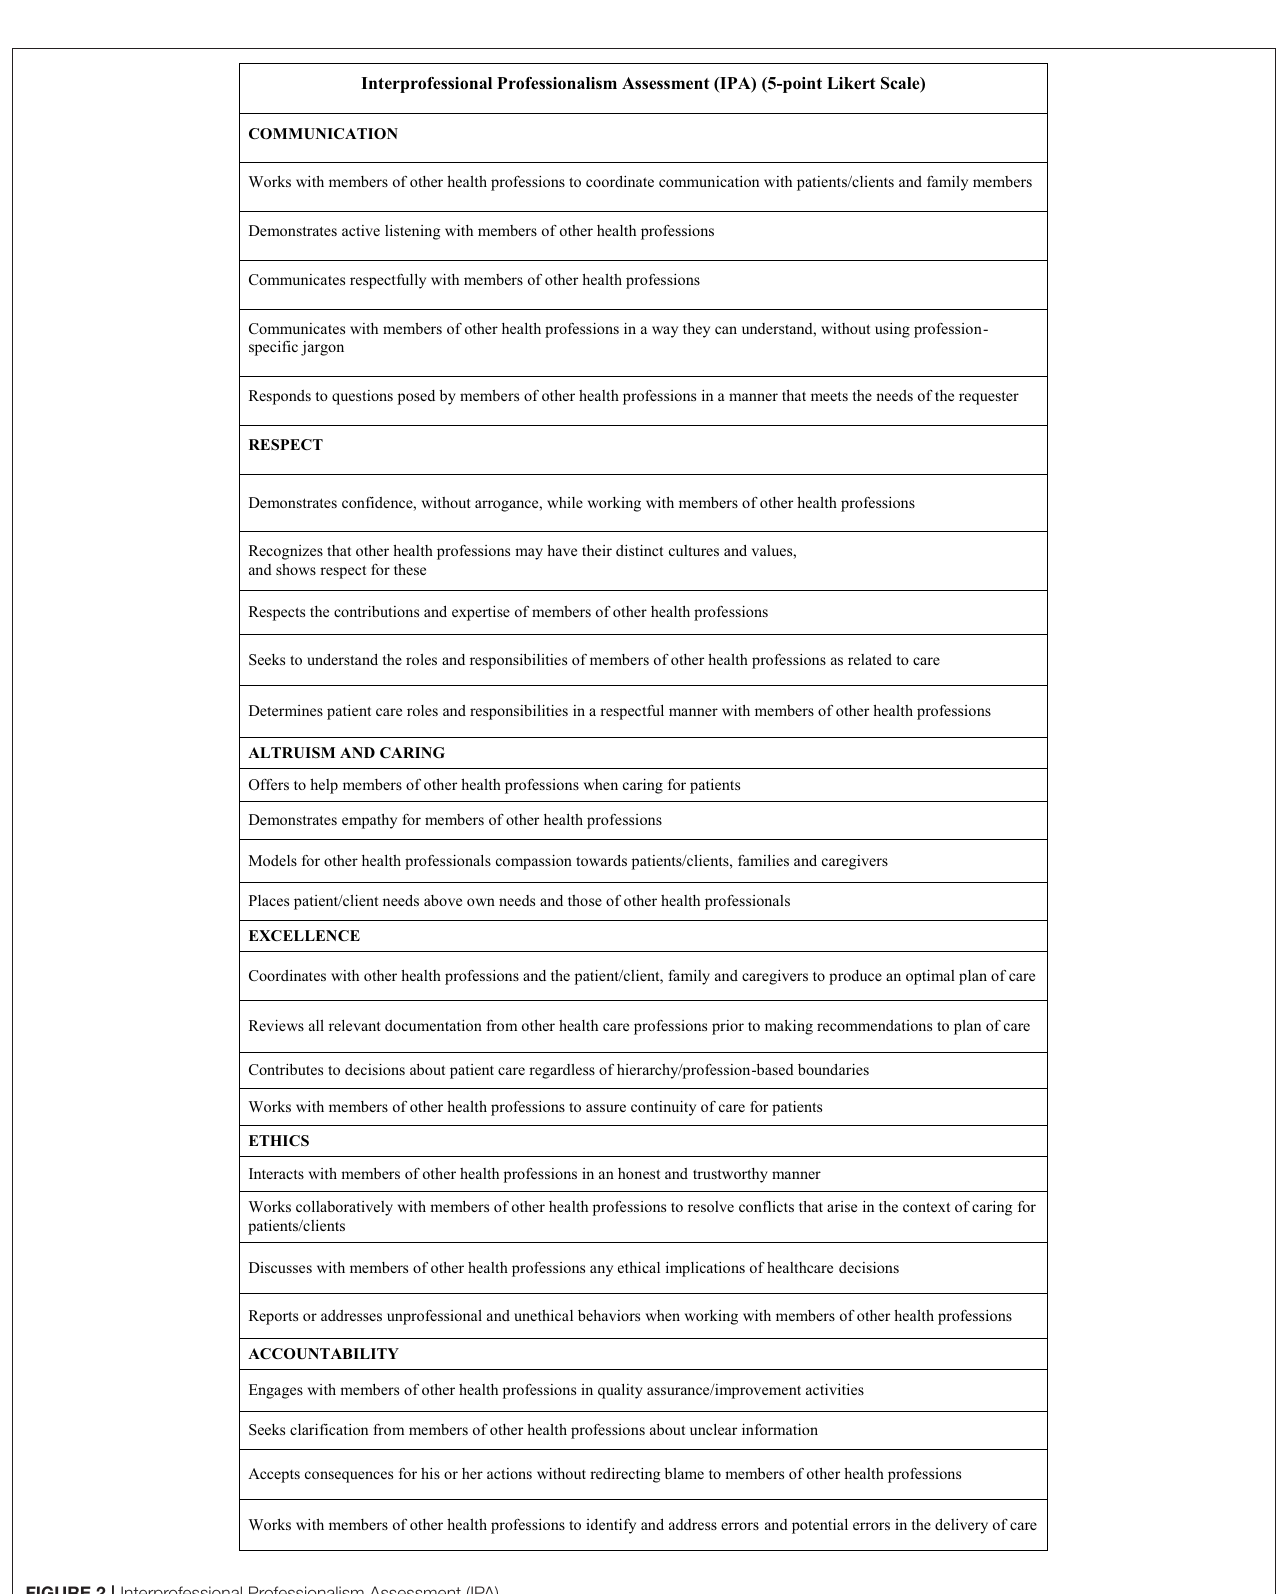
FIGURE 2 | Interprofessional Professionalism Assessment